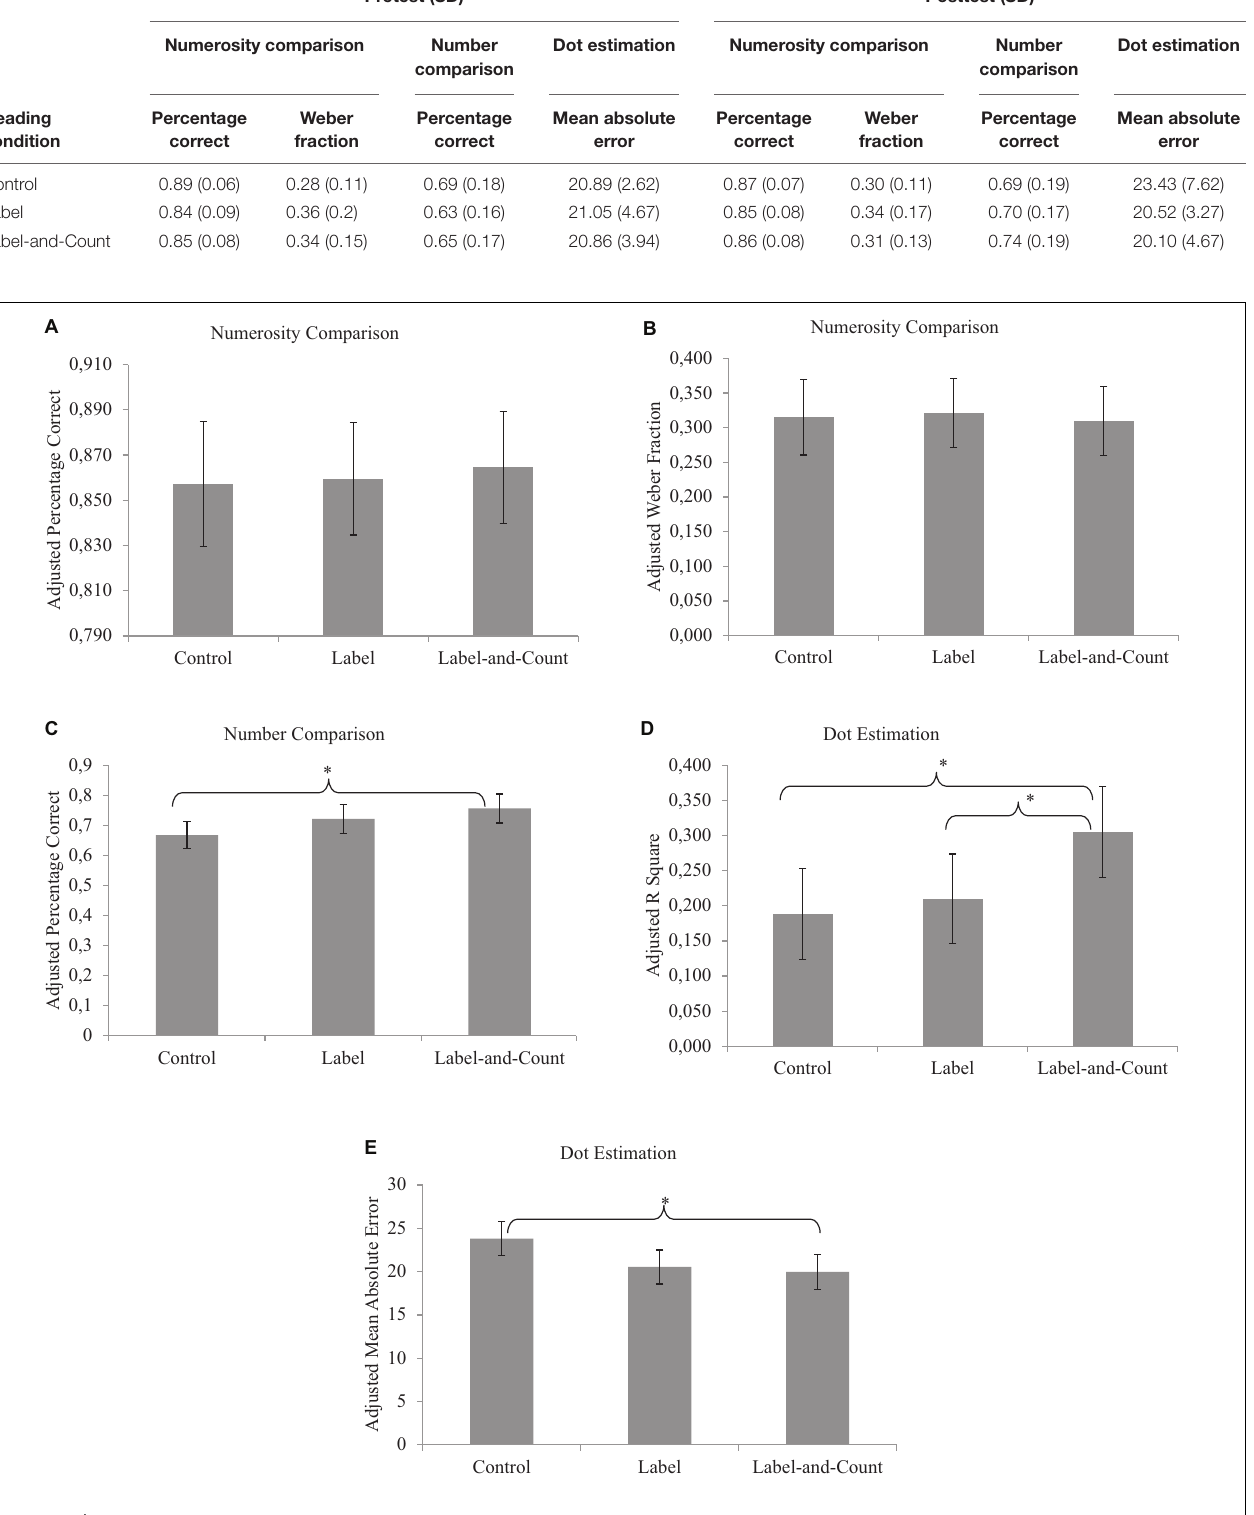
FIGURE 2 | (A–E) Adjusted mean posttest scores of children in different reading conditions. Bars present 95% confidence intervals ( ∗ p <